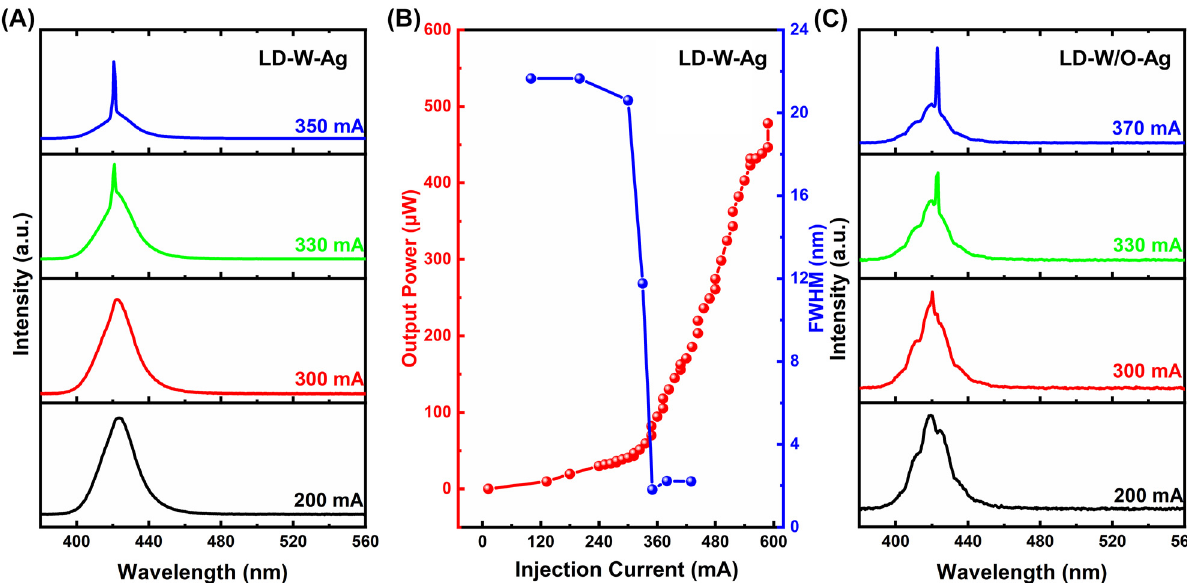
Figure 3: Luminescence performance of GaN-on-Si microring lasers ( R = 50 μ m, r = 30 μ m). (A) EL spectra of LD-W-Ag measured under various pulse injection currents, (B) FWHM and light output power of LD-W-Ag as a function of injection current. (C) EL spectra of LD-W/O-Ag measured under various pulse injection